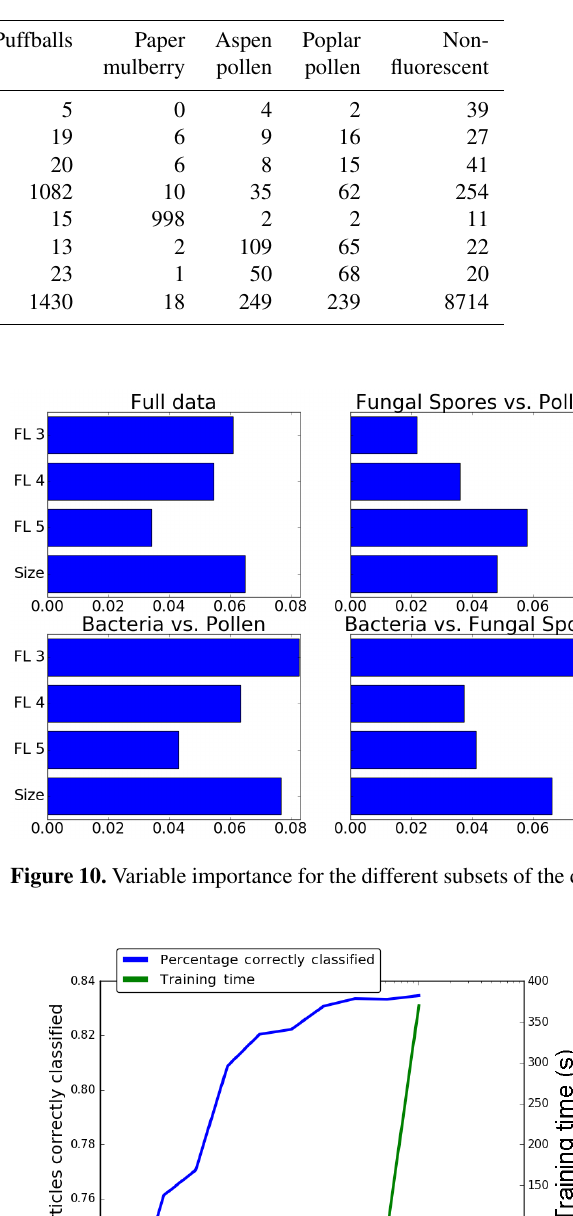
have identified the gradient boosting classifier as a possible supervised